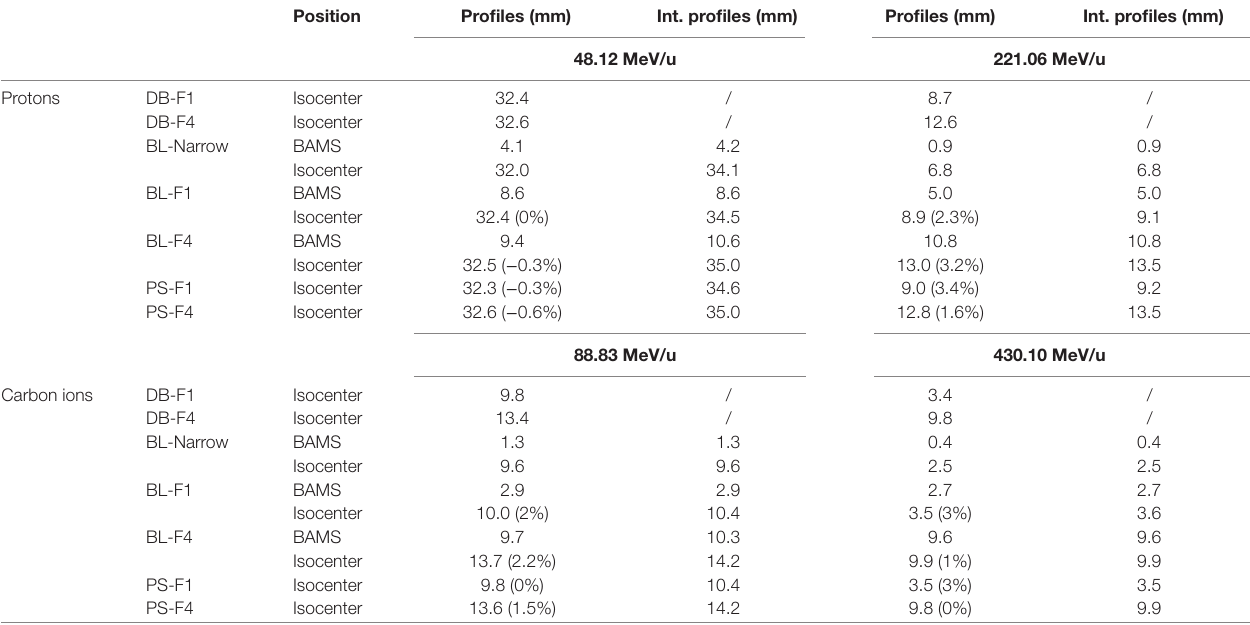
TaBle 2 | FWhM, in millimeter, of the different fluence distributions for protons and carbon ions, with respect to the reference one from the liBc: FWhM values for profiles sampled at the center of the beam spot and for vertically integrated profiles (int. profiles), for two positions in depth in air (exit of the BaMs and isocenter) for both foci 1 and